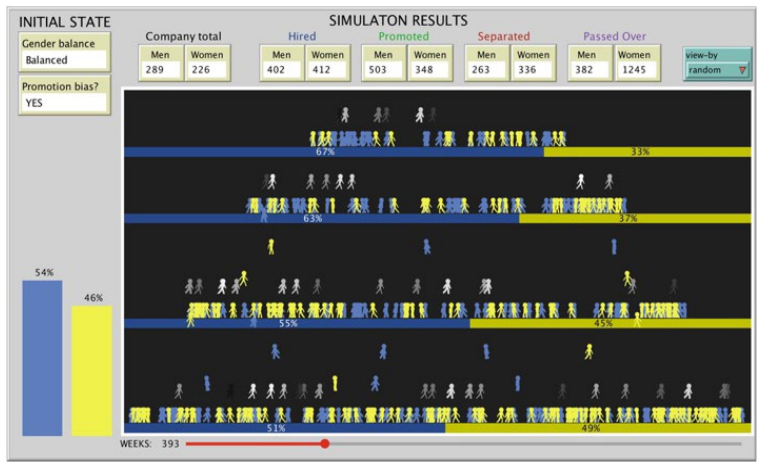
Figure 1. Screenshot of the simulation, see text. At the start of each simulation “run,” employees are distributed across ranks in a way that mimics a typical company, with smaller numbers of employees at higher ranks. Unless otherwise stated, the simulation starts with a 50–50 gender split at each